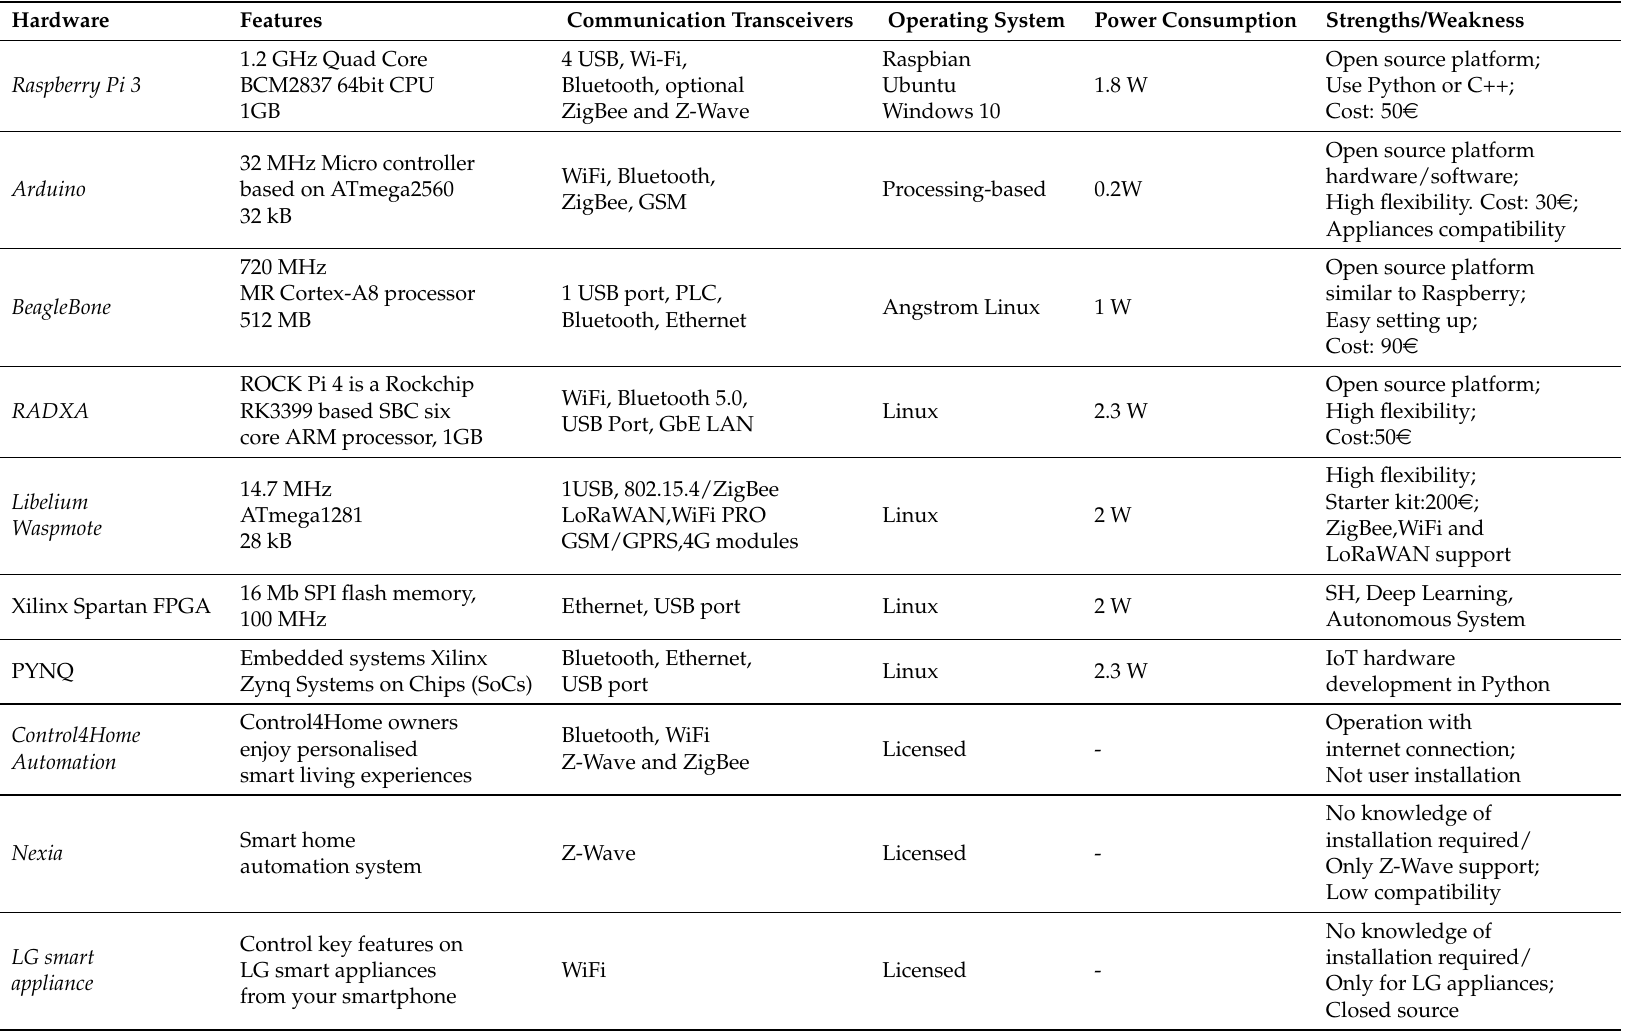
Table 6. Hardware